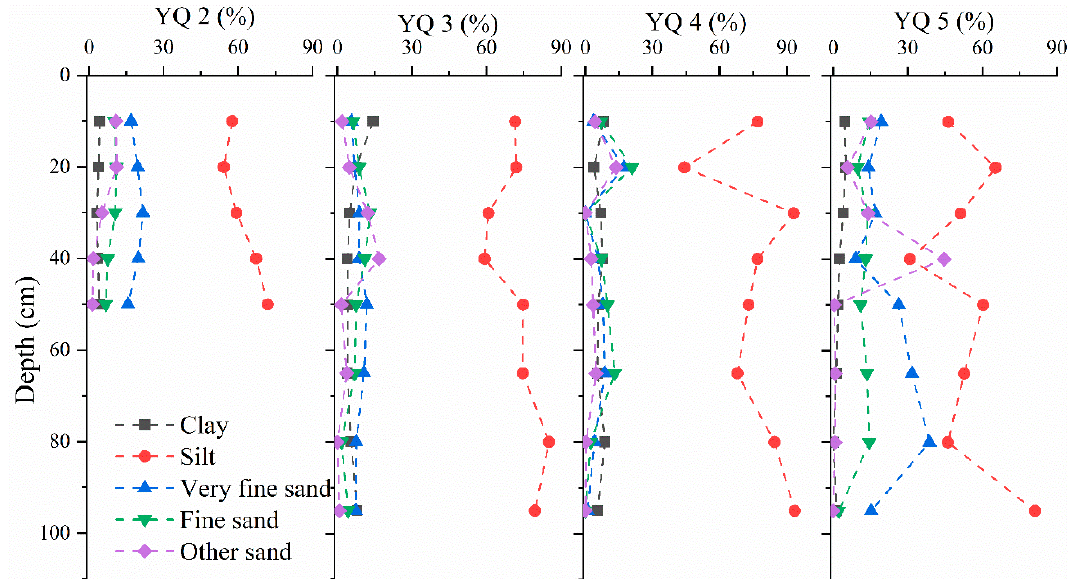
Figure 2. The vertical variation of particle size distribution at four sites.